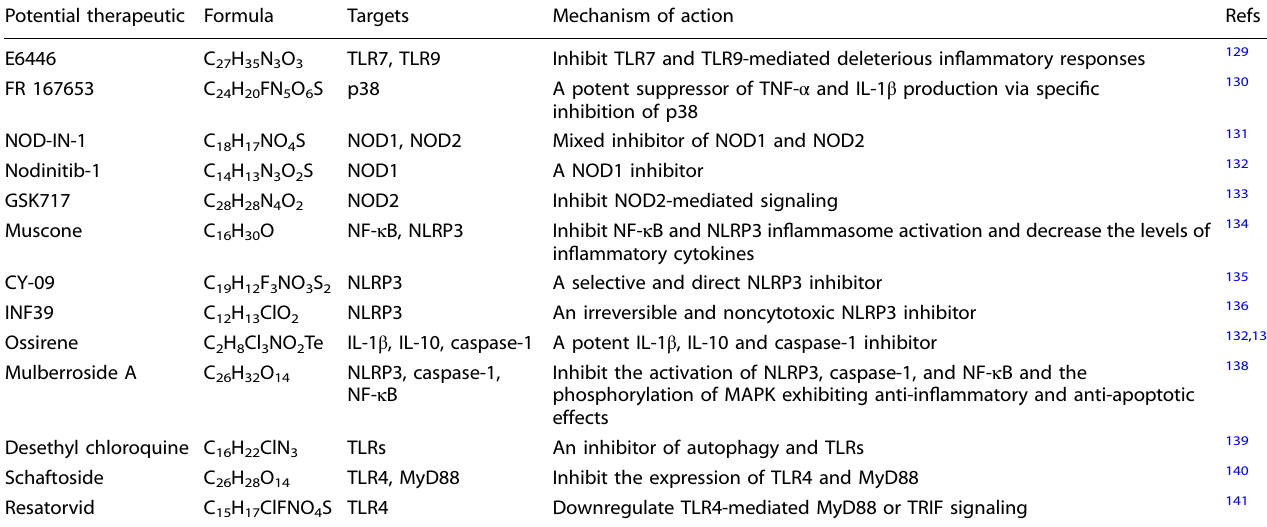
Table 1. Summary of existing pharmacological modulators that act directly or indirectly on innate immune receptors-mediated in fl ammatory responses in endothelial